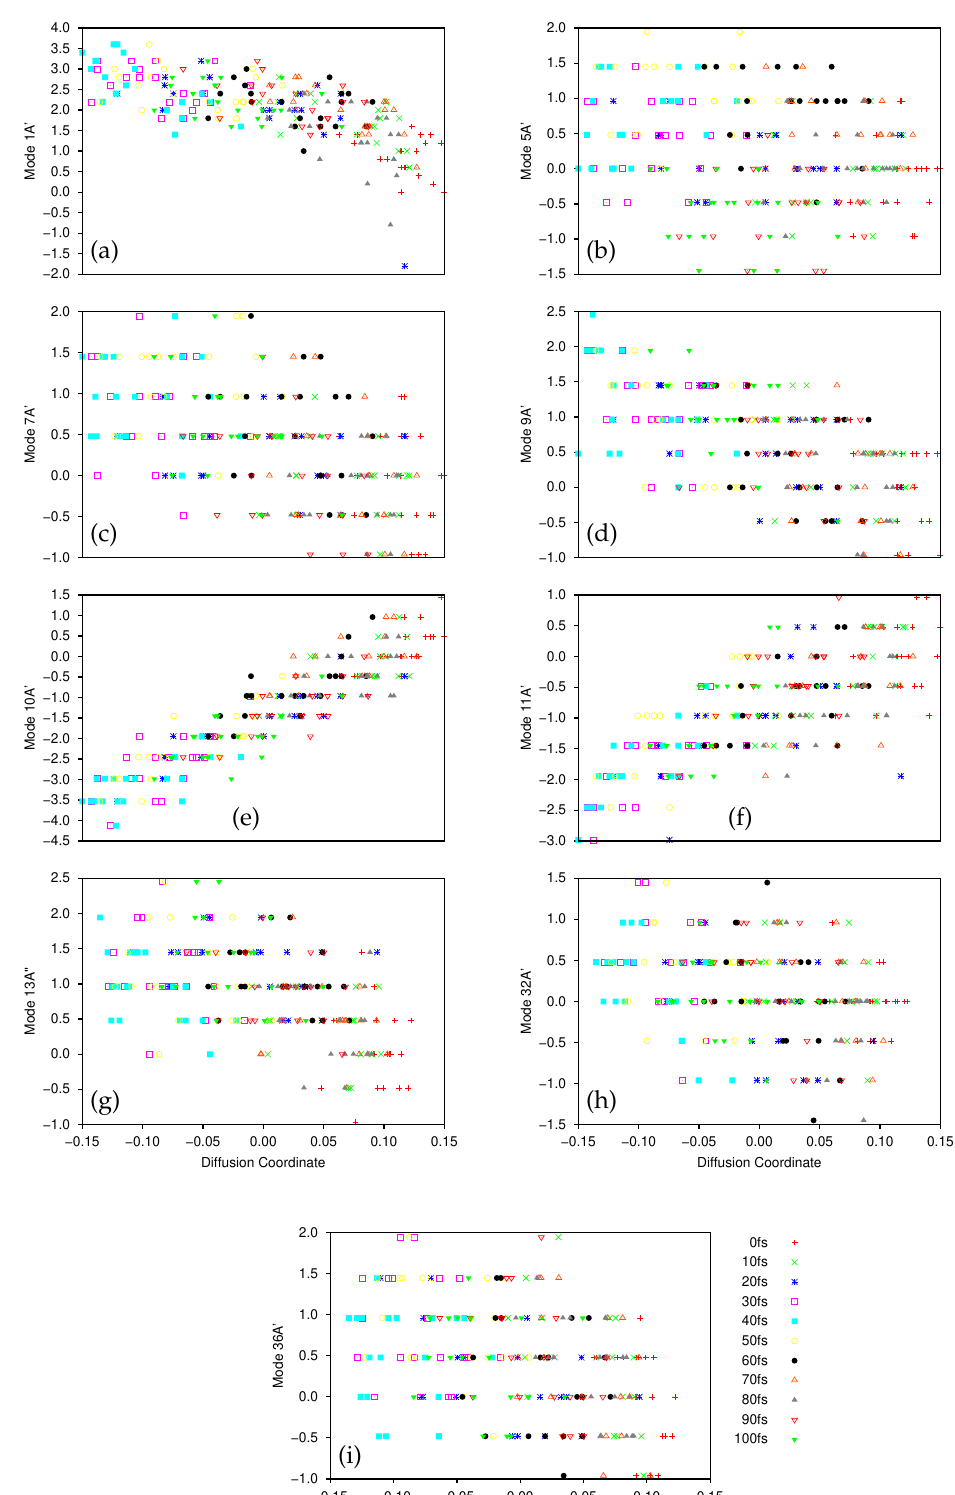
Figure 3. Sampled normal mode coordinates of salicylaldimine plotted as functions of the diffusion coordinate: ( a ) Mode 1A’; ( b ) Mode 5A’; ( c ) Mode 7A’; ( d ) Mode 9A’; ( e ) Mode 10A’; ( f ) Mode 11A’; ( g ) Mode 13A”; ( h ) Mode 32A’; ( i ) Mode 36A’. In all cases data points are coloured according to the sample time; 20 gridpoints were sampled every 10fs during the dynamics. The key to the right of plot ( i ) applies to all